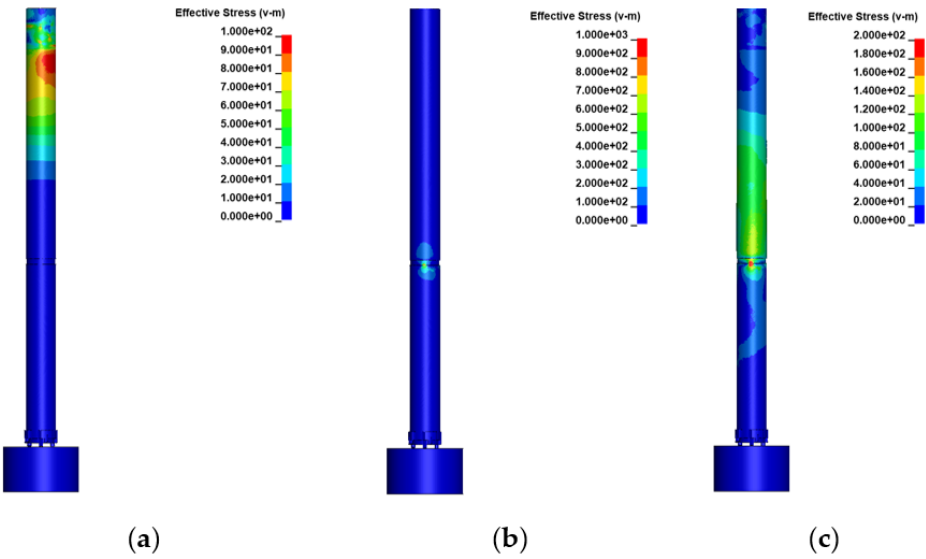
Figure 11. Stress waves during intrusion of lunar rocks by the WSC robot ( a ) Load phase ( b ) Transfer to connection point ( c ) Reflection phase.